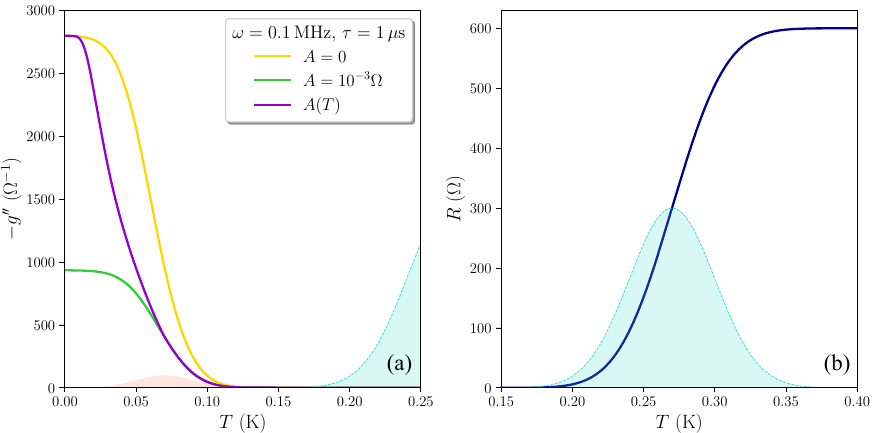
Figure 2. ( a ) Imaginary part of the complex conductance of the three-component RIN within the g (cid:48)(cid:48) , as a function of the temperature T , for R 0 = 600 Ω , L 1 = 1nH, L 2 = 0.5nH, ω = 0.1MHz. EMT, − The Gaussian distribution of the percolating superconducting cluster P s 1 ( T c ) , with mean value T c,1 = 0.27K, variance σ 1 = 0.03K and weight w s1 = 1 , is shaded in light blue; the proximized 2 fraction distribution P s 2 ( T c ) is shaded in red, its parameters are T c,2 = 0.07K, σ 2 = 0.02K and w s2 = 7 . All the three curves are calculated for τ = 1 µ s while the values of A are indicated in 100 the legend. For the violet curve we took a temperature dependence A ( T ) = A 0 min [ e − ( T c,2 − T ) / T ;1 ] , with A 0 = 10 − 3 Ω , to describe the thermal excitation of vortices, which is exponentially suppressed at T = 0K. ( b ) The blue curve gives the sheet resistance of the system above percolation, where the effects of Z V are negligible. All the calculations are carried out assuming zero magnetic